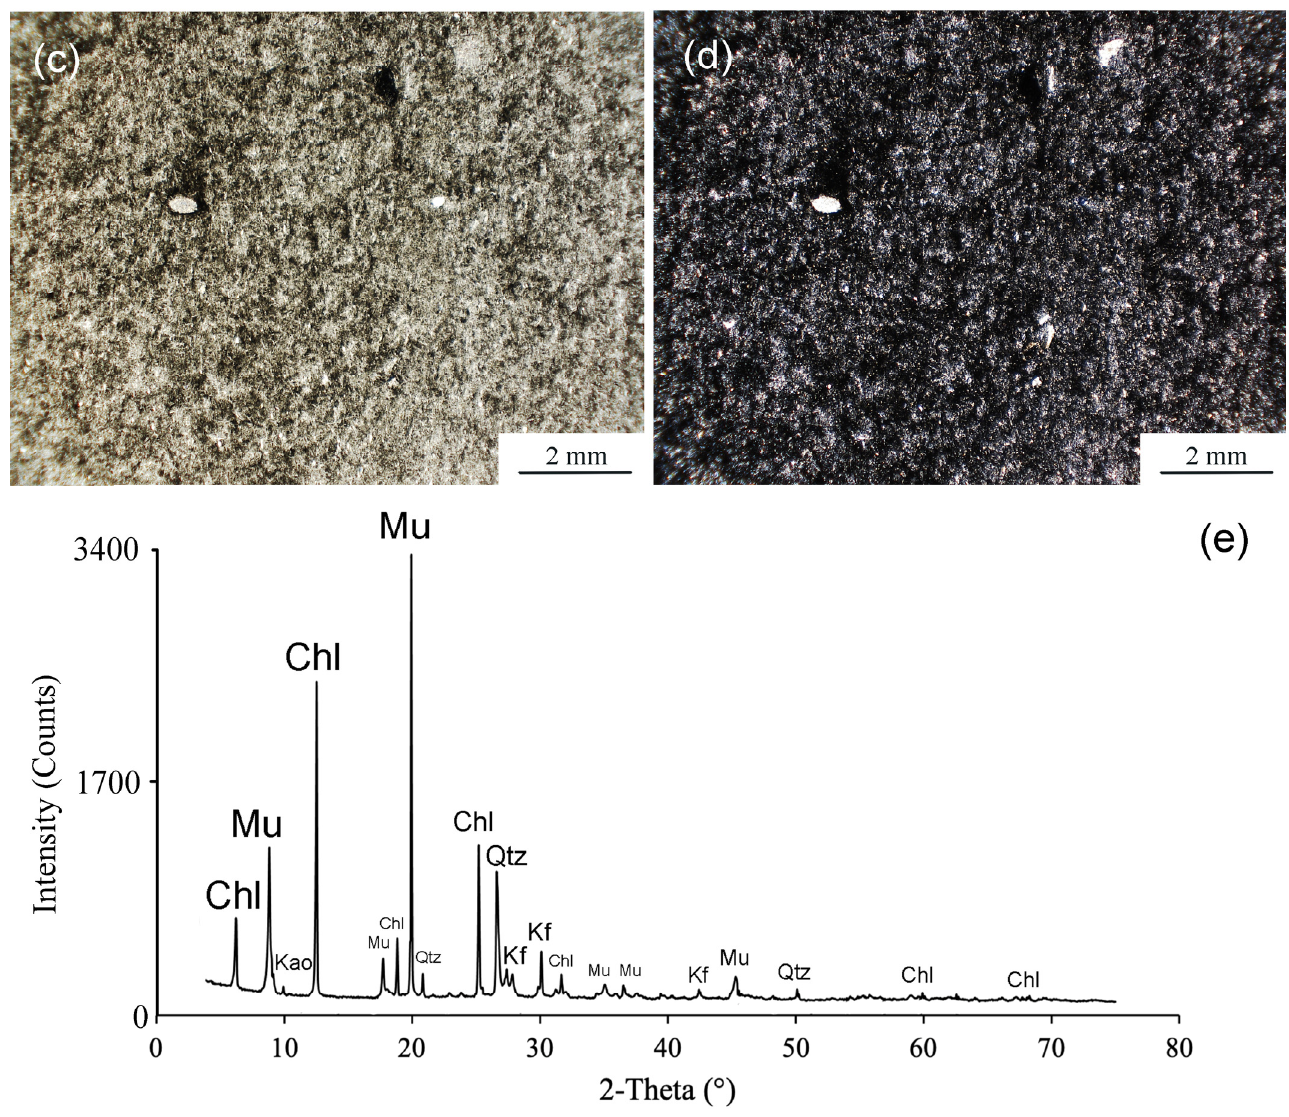
Figure 3. Petrography and mineralogy of the Valongo slate: ( a ) thin section parallel to cleavage (PPL); ( b ) thin section parallel to cleavage (NC); ( c ) thin section perpendicular to slaty cleavage (PPL); ( d ) thin section perpendicular to cleavage (NC); ( e ) semi-quantitative X-ray diffraction data with peaks corre- sponding to: Clinochlore (Chl, (MgFe) 5 Al(Si 3 Al)O 10 (OH) 8 ), Muscovite (Mu, KAl 2 (AlSi 3 O 10 )(F,OH) 2 ), Kaolinite (Kao, Al 2 Si 2 O 5 (OH) 4 ), Quartz (Qtz, SiO 2 ), Potassium feldspar (Kf, KAlSi 3 O 8